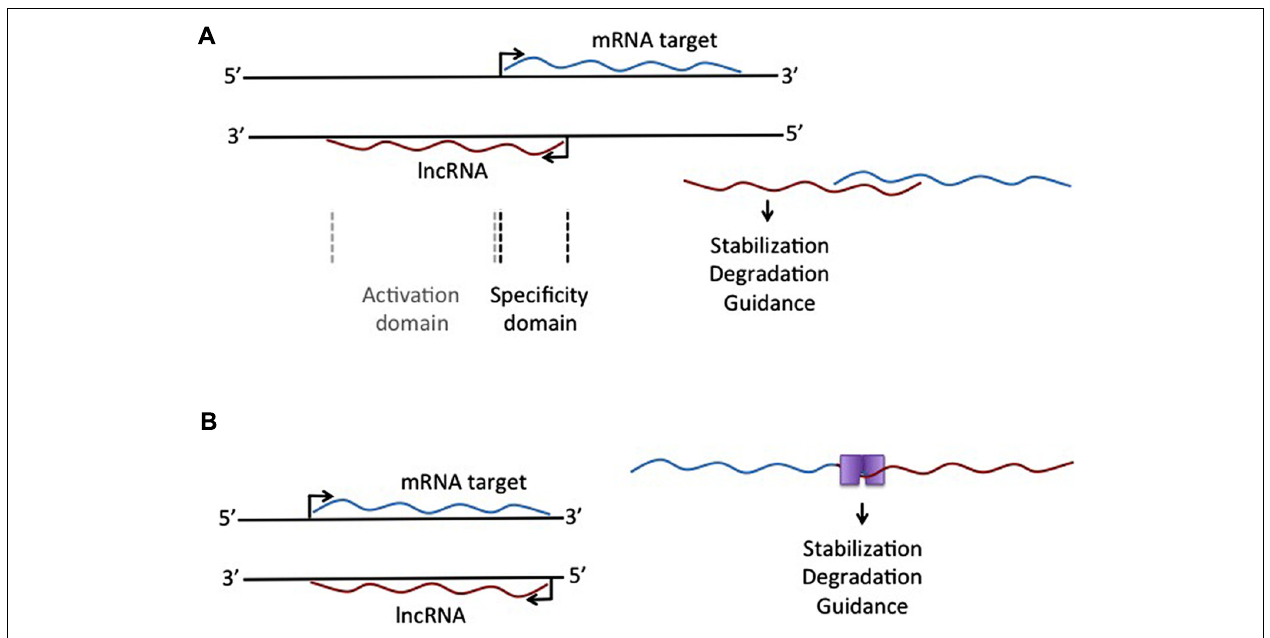
binding for different molecules, leading to stabilization or degradation of the RNA:RNA complex. (B) Complementary binding of overlapping mRNA and lncRNA could create a double-stranded binding site for protein binding, leading to selective degradation of stabilization of the RNA:RNA